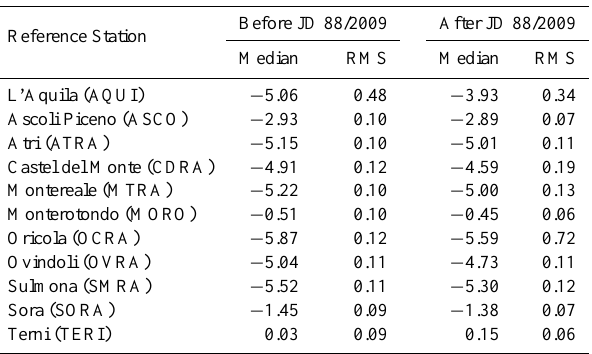
Table 4. The ionospheric propagation delay for satellite PRN29 expressed in meters.